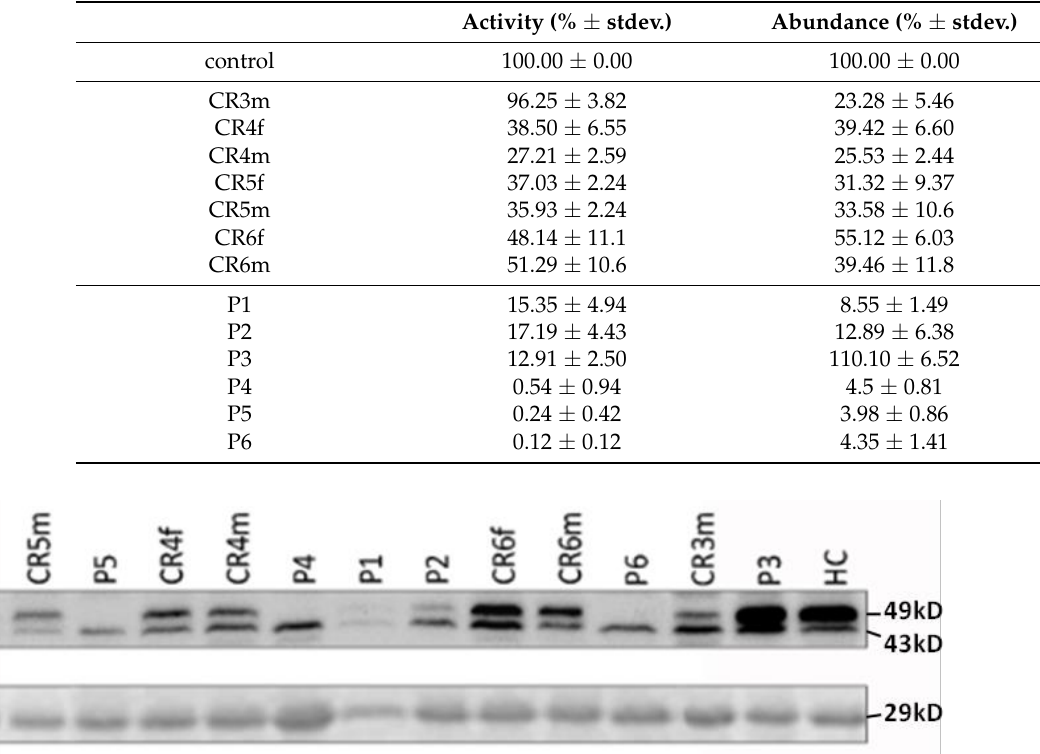
Figure 1. Abundance of PANK2 protein in erythrocytes of patients affected by PKAN and disease carriers. Hemoglobin-depleted cytosolic extracts were resolved by SDS PAGE and analyzed by Western blotting on a nitrocellulose membrane using a polyclonal rabbit anti-PANK2 antibody. Carbonic anhydrase (CA) was detected by a rabbit monoclonal antibody and served as loading control to assess the specific abundance of the PANK2 protein. HC refers to a sample obtained from a healthy control donor used for normalization to calculate the relative abundance of PANK2 in the patient and carrier samples.